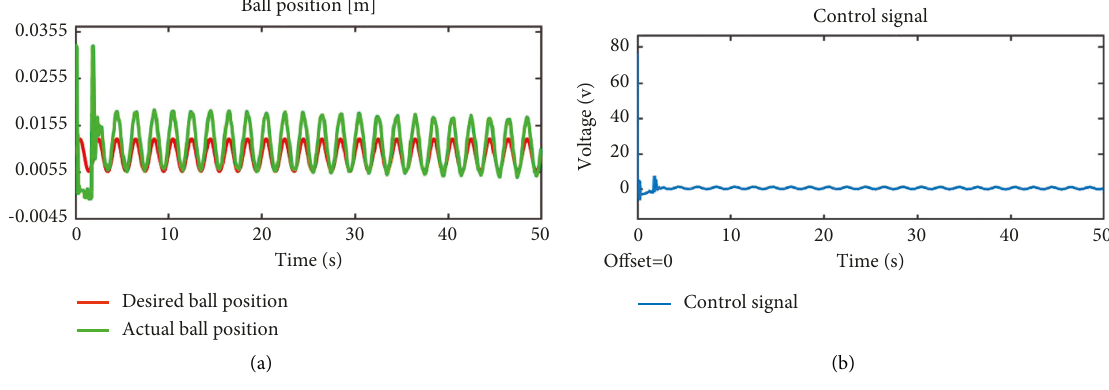
Figure 4: SINE output and control signal for the PID controller.